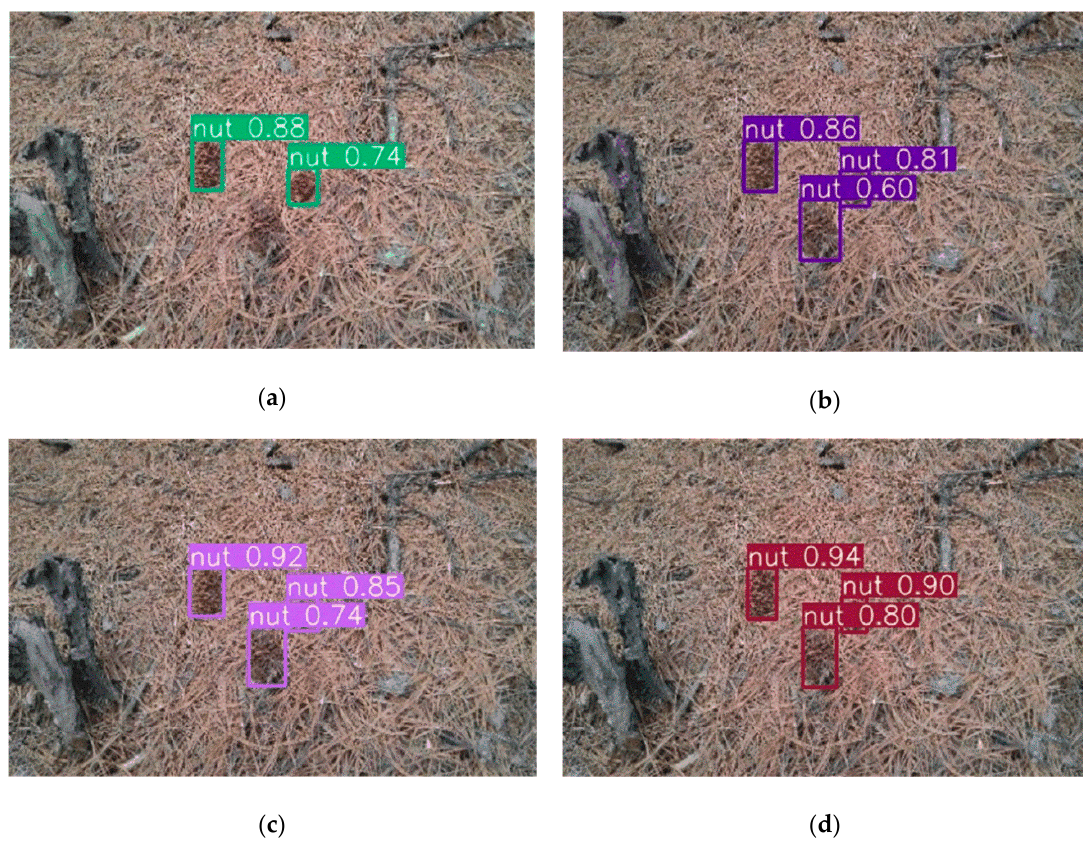
Figure 18. Detection result: ( a ) YOLOv3; ( b ) YOLOv3 with DenseNet; ( c ) YOLOv3 with DenseNet and four detection; ( d ) YOLOv3 with DenseNet, four detection and DIoU loss.